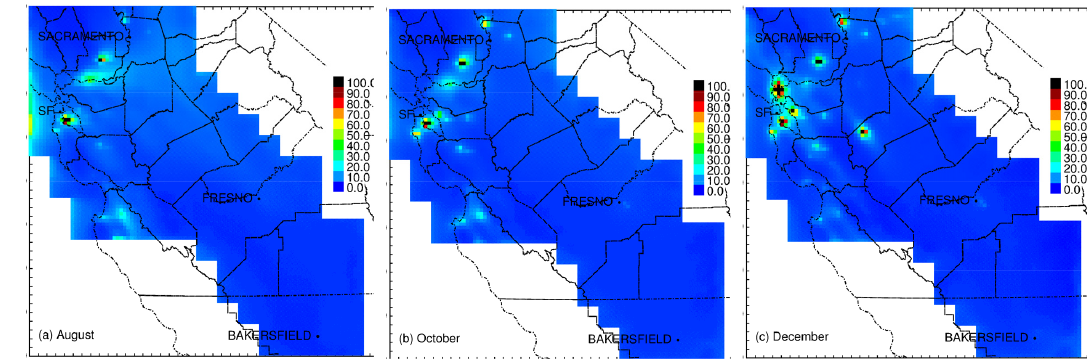
Figure 21. Seasonal variation of nucleated particle concentrations in northern California. Units are kcountscm − 3